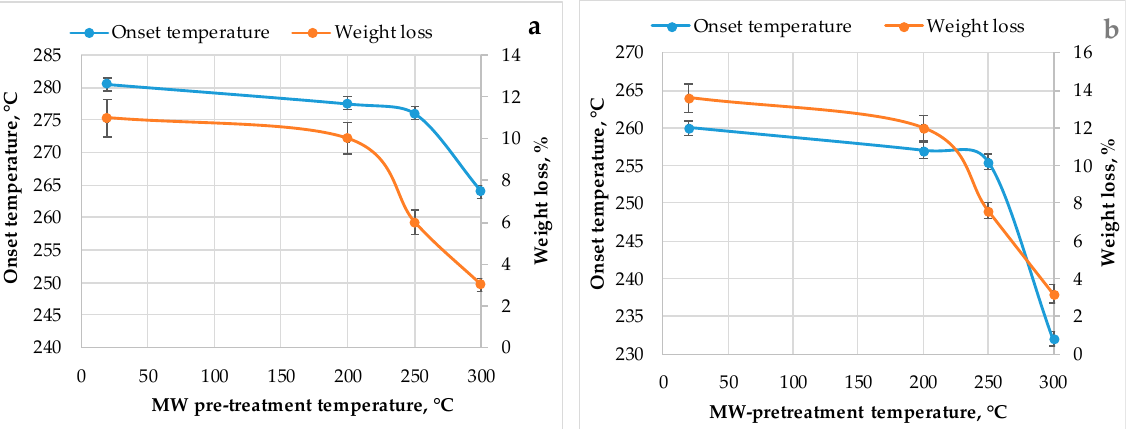
Figure 3. The effect of MW pre-treatment temperature on the weight loss and onset temperatures values at which exothermic effect occurred for pretreated and non-treated (20 °C) biomass according to DTA analysis: ( a ) softwood; ( b ) wheat straw [21].